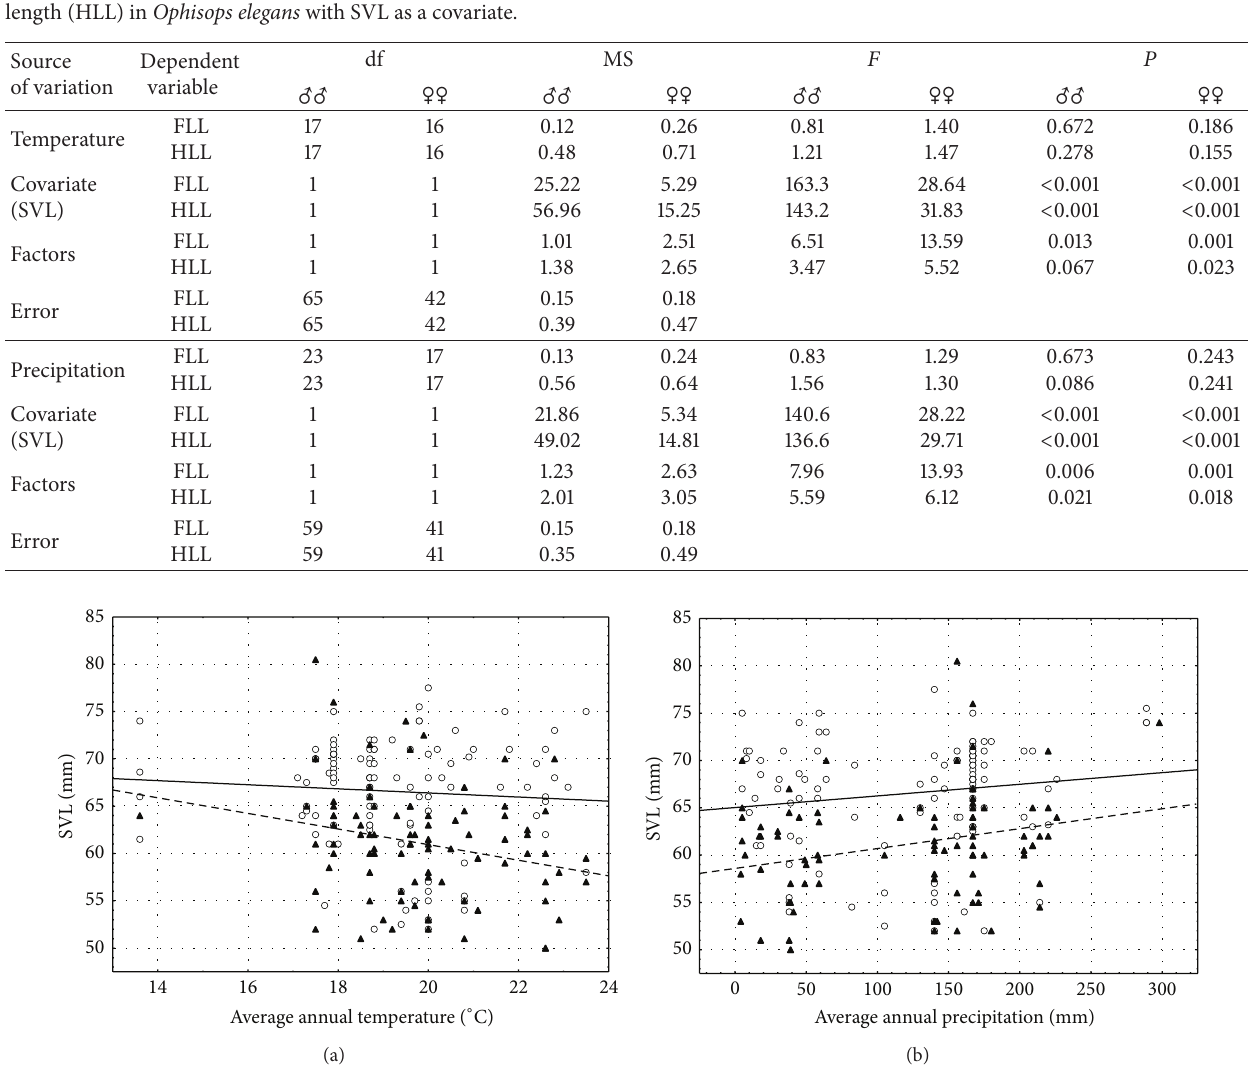
Figure 4: The relationship between SVL and (a) average annual temperature and (b) average annual precipitation in Acanthodactylus boskianus : solid line with circles: males; dashed line with triangles: females. 𝑃 = 0.019 , 𝛽 = 0.21±0.09 , versus 𝑃 = 0.680 , 𝛽 = −0.03±0.09 , for males; 𝑃 = 0.001 , 𝛽 = 0.33 ± 0.09 , versus 𝑃 = 0.134 , 𝛽 = −0.14 ± 0.09 , for females,